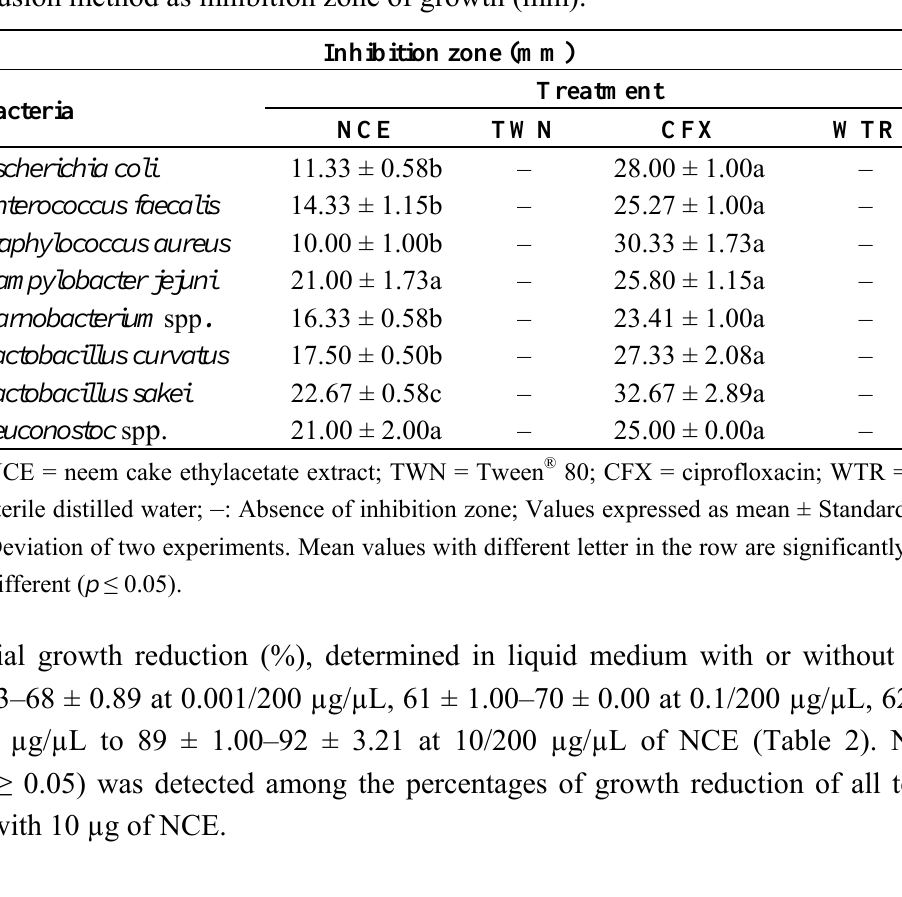
Table 1. Antimicrobial activity of NCE against zoonotic and spoilage bacteria detected by disc diffusion method as inhibition zone of growth